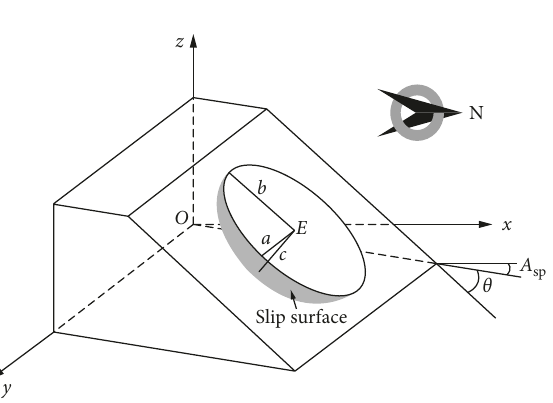
Figure 4: Attitude control of